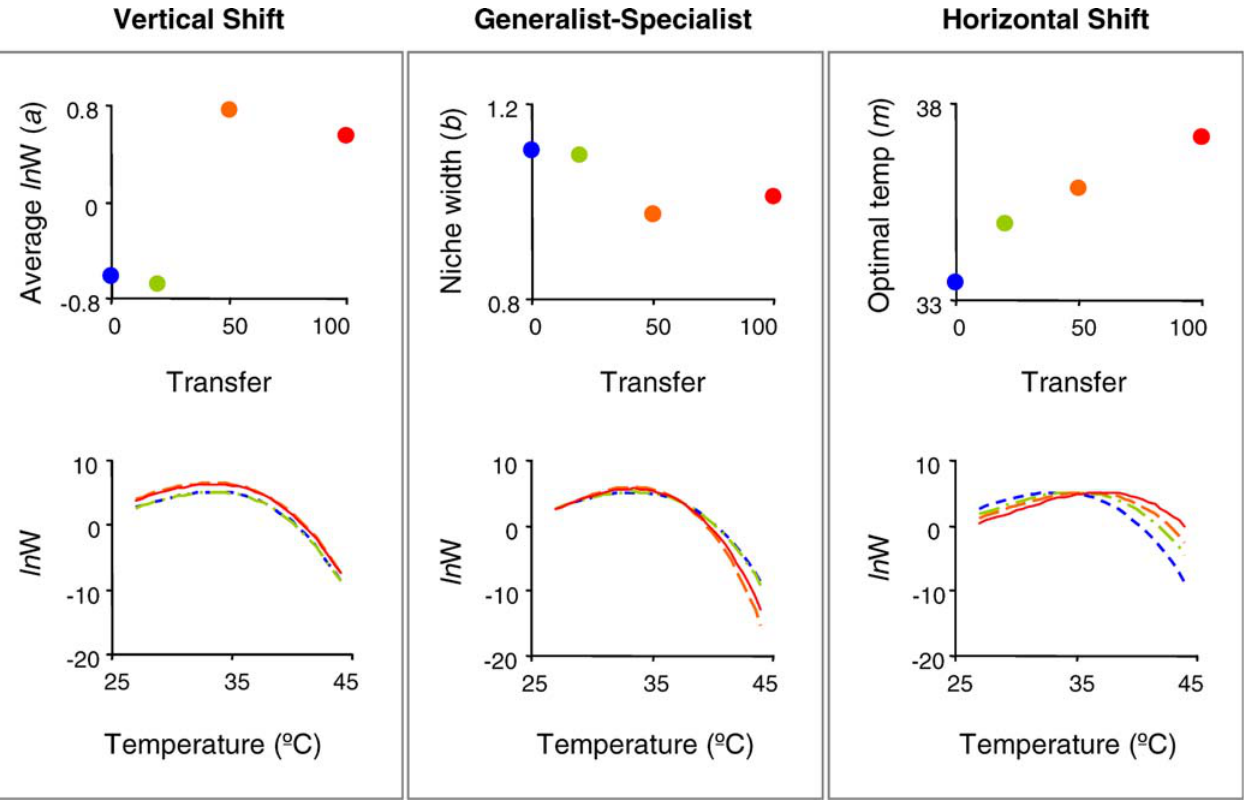
Figure 4. Modes of Variation among the Reaction Norms of Evolving Genotypes TMV was used to decompose the variation among the reaction norms described in Figure 3 into three modes of variation. Each uppermost graph depicts the values of the fitted parameters from the model and the bottom graphs illustrate the impact of each parameter, if considered alone, on the shape of the reaction norm of G4 0. lnW is the natural log of growth rate. DOI: 10.1371/journal.pbio.0040201.g004